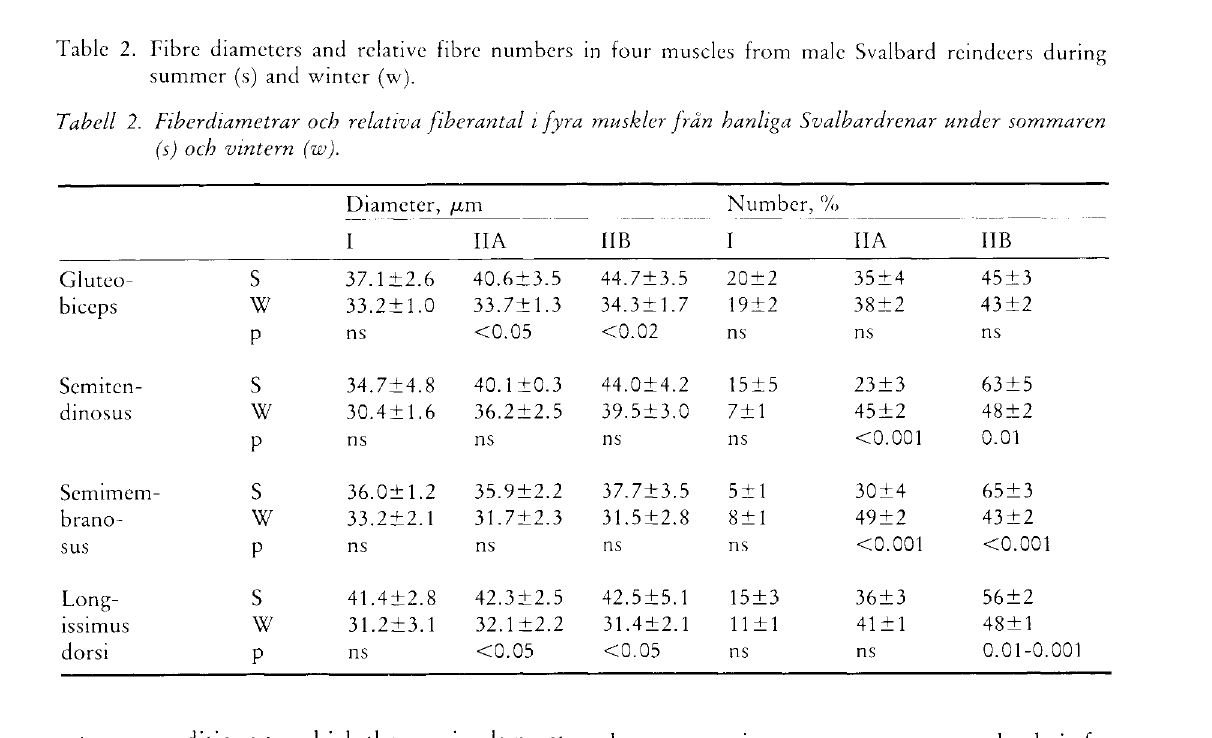
Table 2. Fibre diameters and relative fibre numbers in four muscles from male Svalbard reindeers during summer (s) and winter (w).